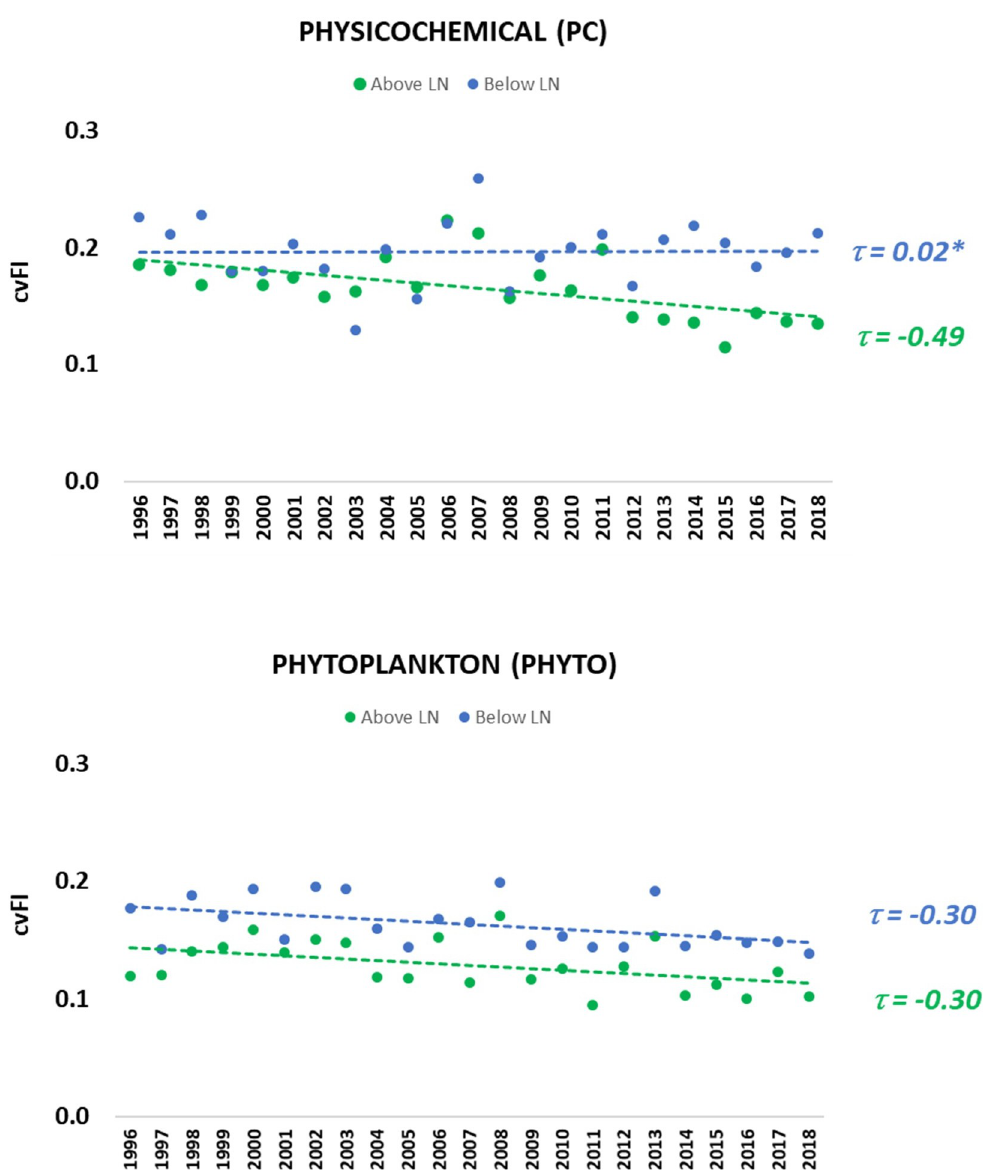
Fig 8. Spatiotemporal variation in biophysical condition above and below the Limes Norrlandicus (LN). The cvFI serves as a measure of variation around the mean; hence, lower cvFI values indicate increasing stability. The statistically significant Kendall’s tau correlation values (p-value < 0.05) show the strength of the trend. Note: � indicates that the correlation was not statistically significant (p-value >